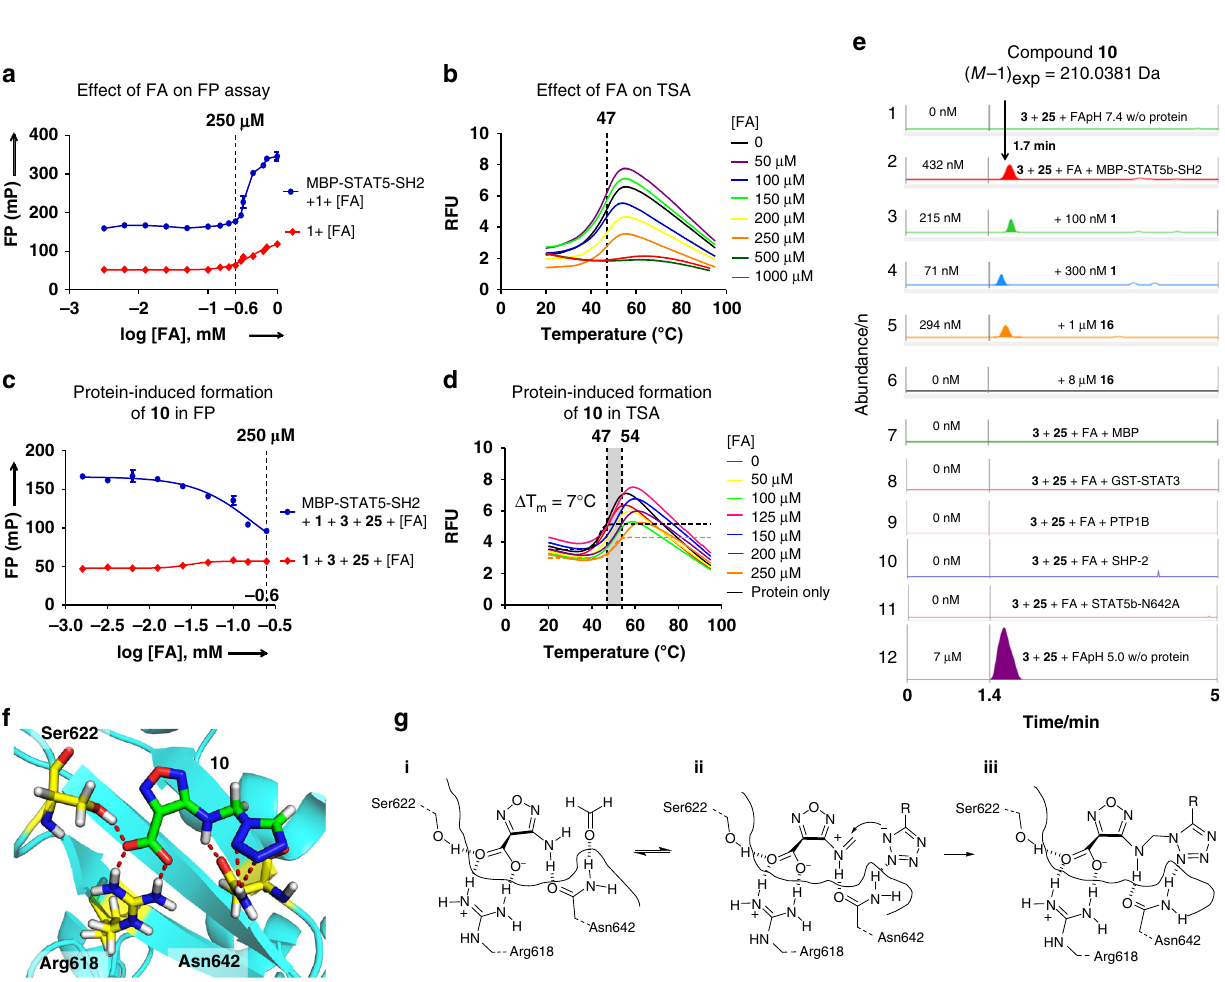
MBP-STAT5-SH2 protein was not present (trace 1). With 250 n M MBP-STAT5-SH2 in the buffer at pH 7.4, 432 n M of 10 were formed over 24 h (average of three independent experiments). The protein-dependent reaction was saturated after 24 h, no signi fi cant changes in product concentration were observed between 24 and 48 h reaction time — suggesting product inhibi- tion of the ligation reaction. Addition of phosphopeptide 1 or